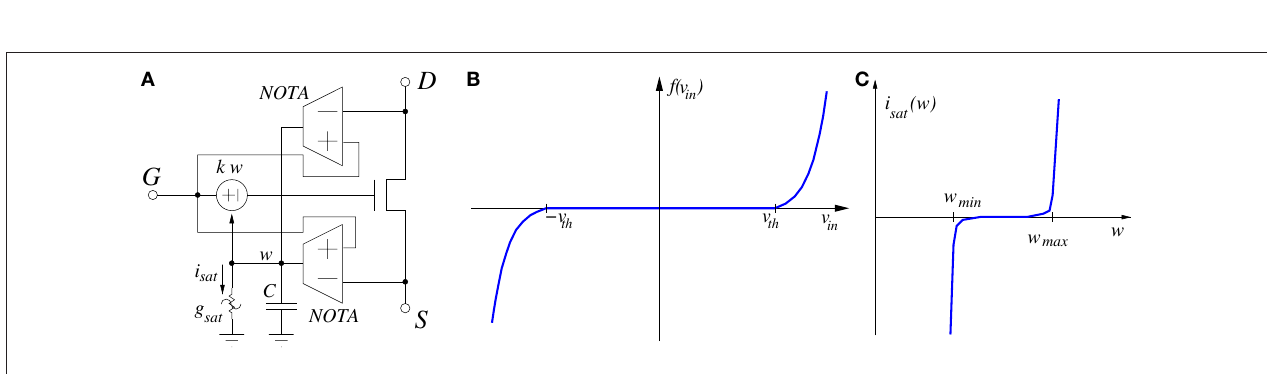
Figure 17 | (A) Memristive type weight update macro-model for a three-terminal FET device. (B) Thresholding and exponential weight update function. (C) Weight saturation function.